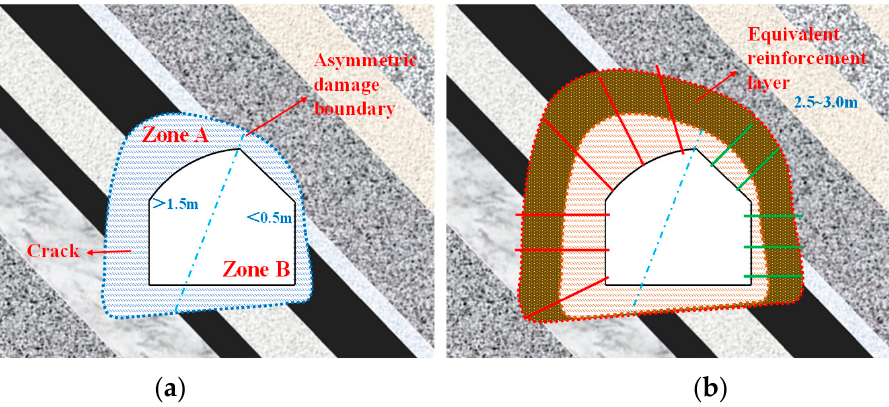
Figure 13. Asymmetric deterioration characteristics and equivalent reinforcement principle of the roadway in the steeply inclined coal seam. ( a ) Sketch of the asymmetric distribution of cracks; ( b ) equivalent reinforcement effect.